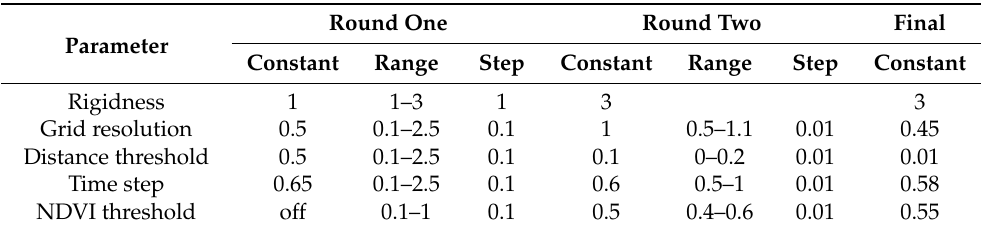
Table 1. Cloth simulation filter (CSF) parameter and Normalized Difference Vegetation Index (NDVI) threshold testing ranges. Range and step define the limits and spacing of the values over which each parameter was